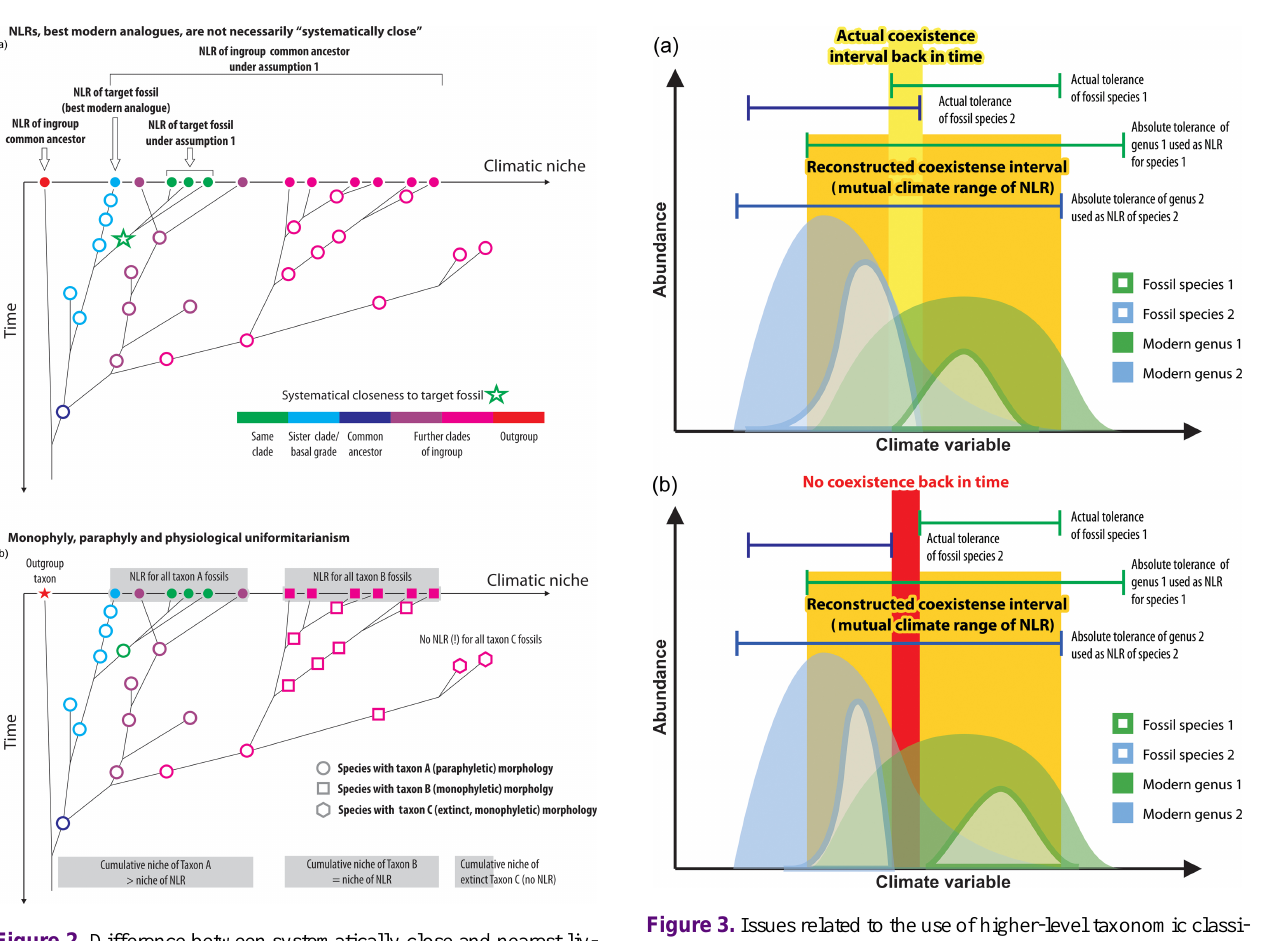
Figure 2. Difference between systematically close and nearest liv- ing relative (NLR, i.e. best modern analogues). Shown is a species phylogeny of a diversified ingroup; the outgroup in this example is a sister species of the ingroup. Panel (a) : standard definition of nearest living relative (best modern analogue) vs. definition if Assumption 1 of the Coexistence Approach should be fulfilled. Panel (b) : same tree as in (a) , only that each species is categorised as a member of a distinct morphotaxon that can be distinguished in the fossil record. Note that all morphotaxa are mutually exclusive regarding their cli- matic niche, but there is no strict correlation between systematic closeness (phylogeny) and the climatic niche of the fossils and their nearest living relatives (modern species of the same morphotypes as the fossils).